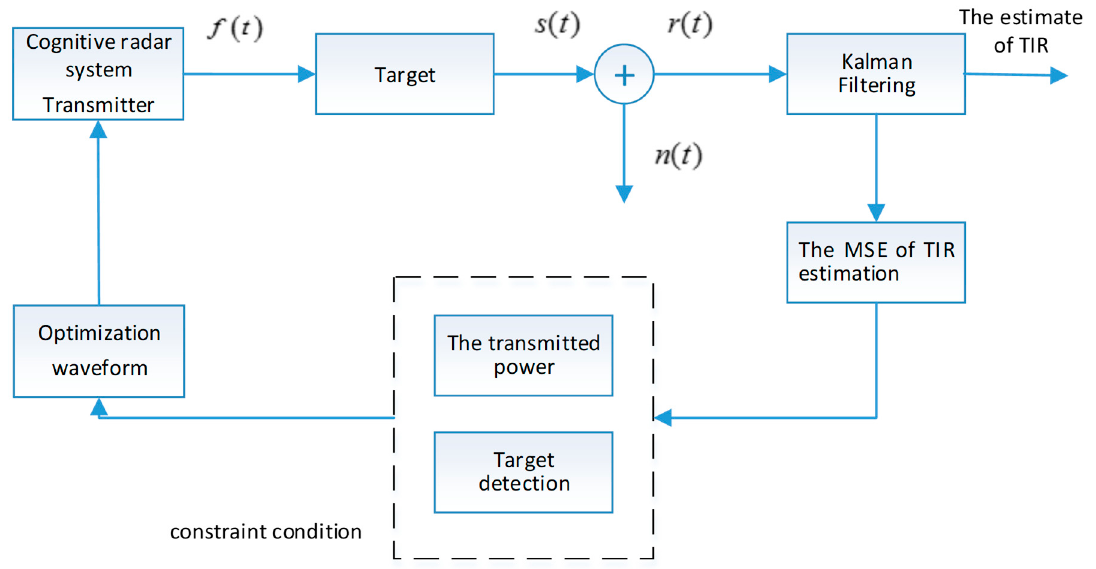
Figure 2. The process of waveform optimization for TIR estimation.